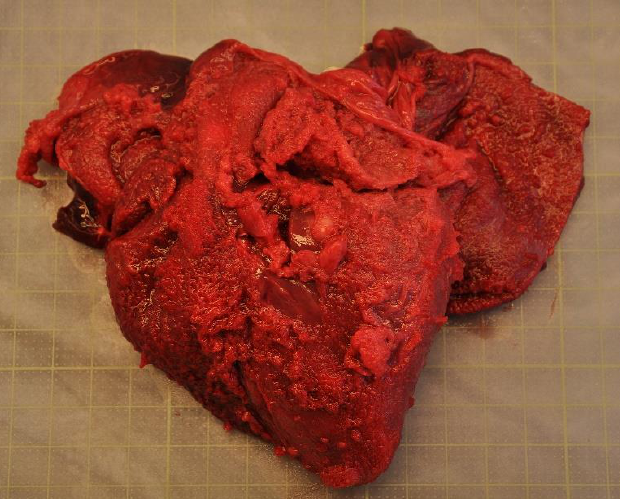
Figure 3. The heart from a harbour porpoise ( Phocoena phocoena ) surrounded by severe fibrinosuppurative pericarditis from Staphylococcus aureus infection.